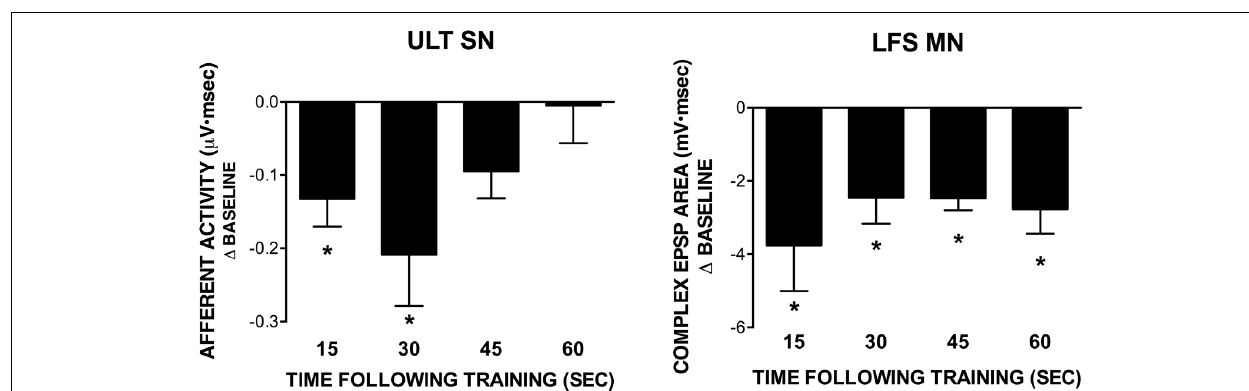
FIGURE 3 | L29 responses during habituation training with either siphon taps or injected current. (A) Comparison of L29 responses during training with either siphon tap or repeated current injection. Data are expressed as a difference score from the first stimulus. At a 1 s ISI (left), a significant reduction is observed in both conditions, with a